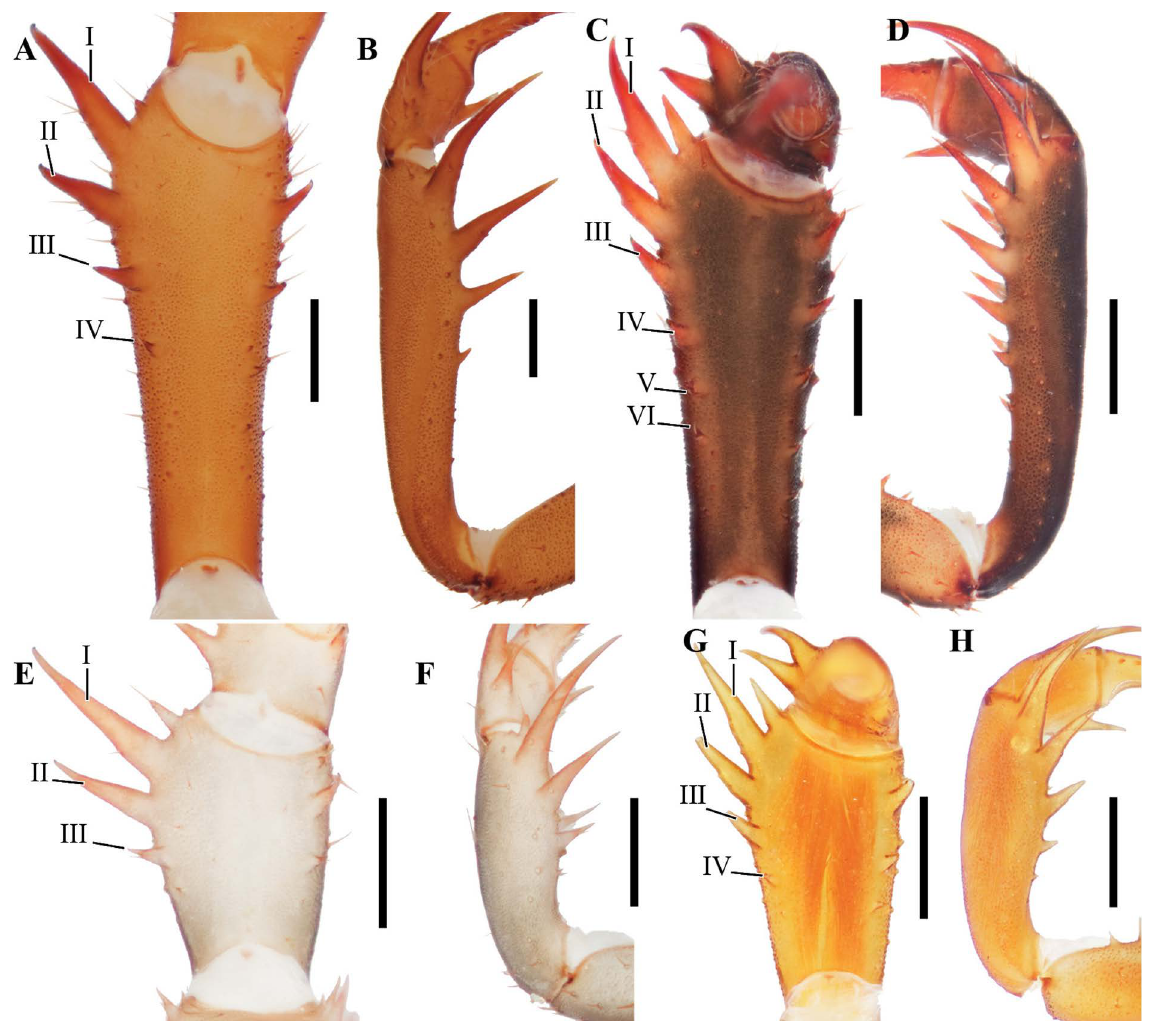
Fig. 4. Charinidae Quintero, 1986, pedipalp patellar articles, dorsal and prolateral views. A–B . Charinus carinae sp. nov. (MNRJ 9293). C–D . Charinus gertschi Goodnight & Goodnight,